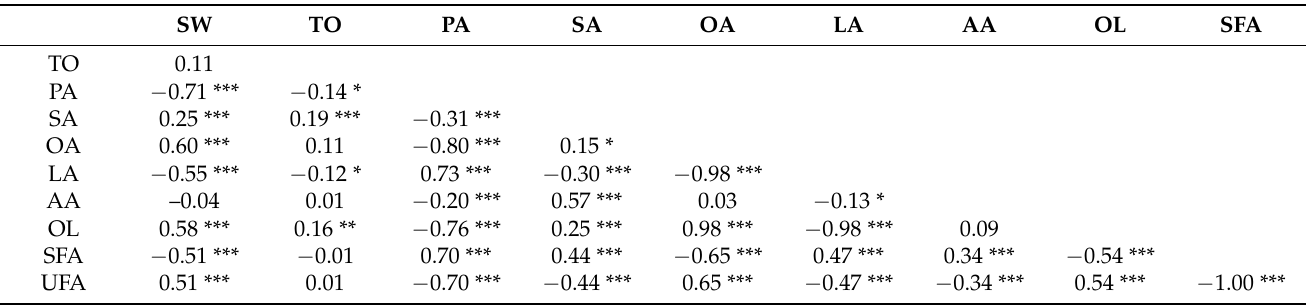
Table 3. Pearson correlation coefficients of seed weight, total oil content, and individual and total fatty acid contents based on analysis of all the